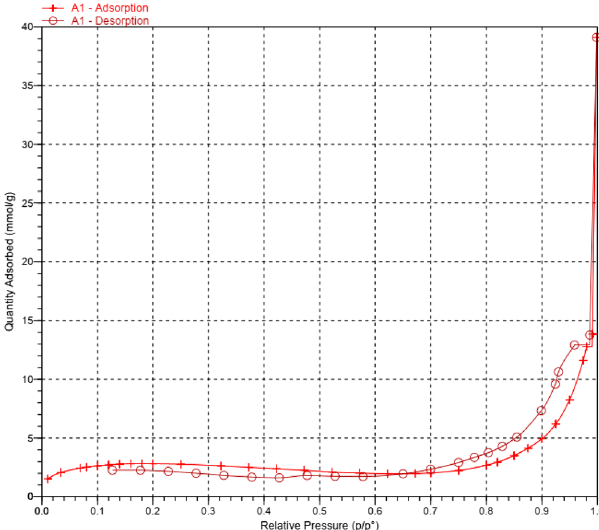
Figure 5. The N 2 adsorption–desorption isotherms of the MCM-41-SO 3 H.